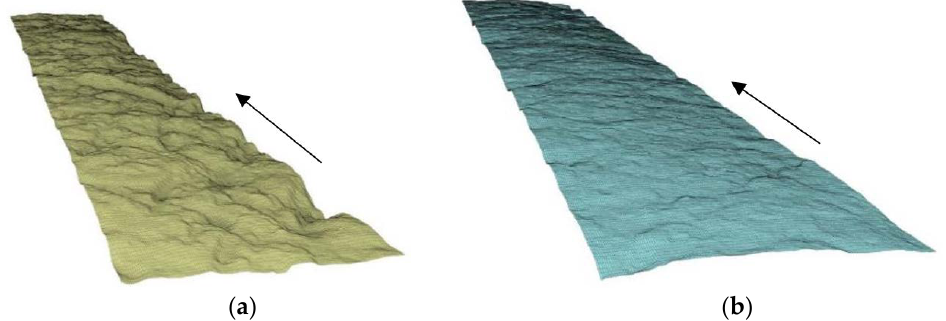
Figure 14. Examples of surfaces with ( a ) high (Ref) and ( b ) low (SE-CE) roughness. Arrows indicate the printing directions.